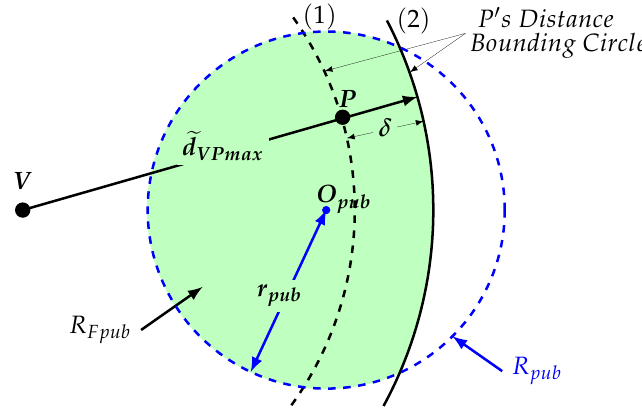
Figure 1. A distance bounding attack